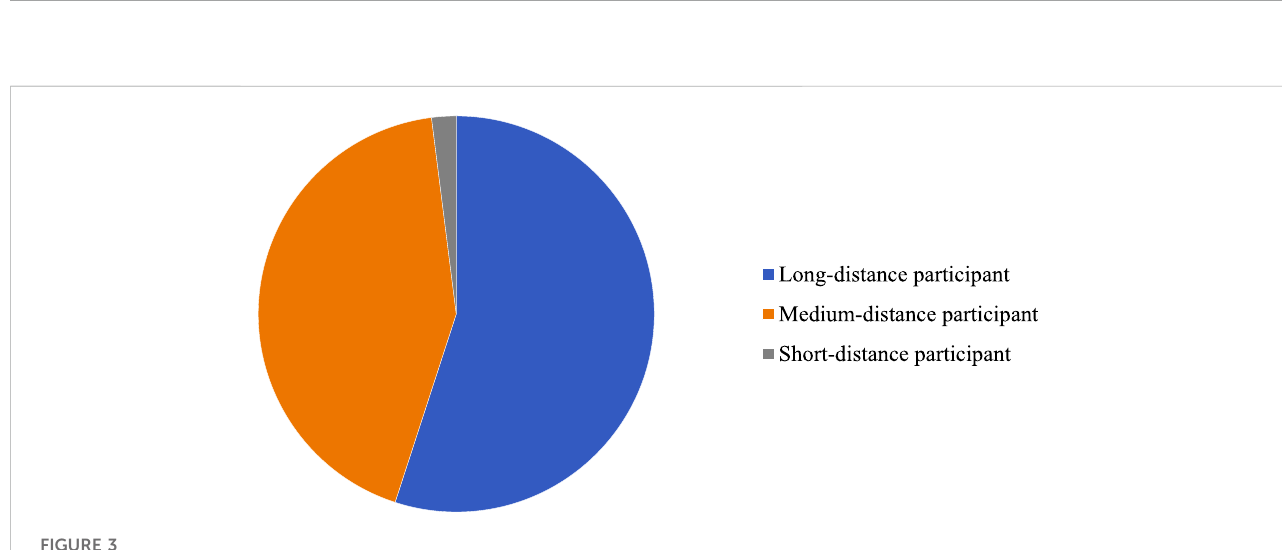
Proportion of carbon dioxide emissions of different round-trip distances in a medium-sized artwork